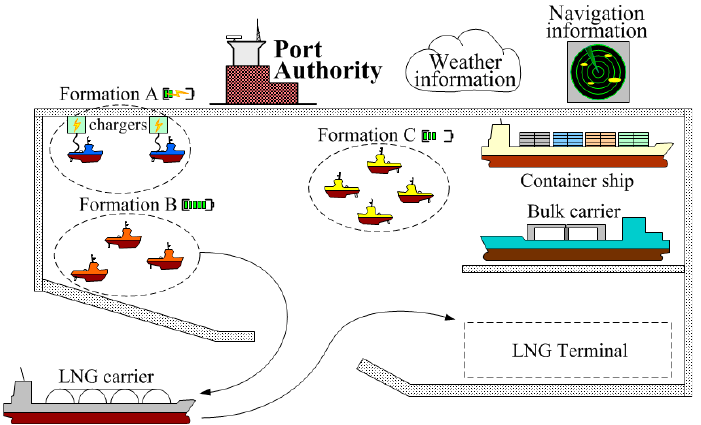
Figure 3. View of an example port using the proposed tugboat formation control system.